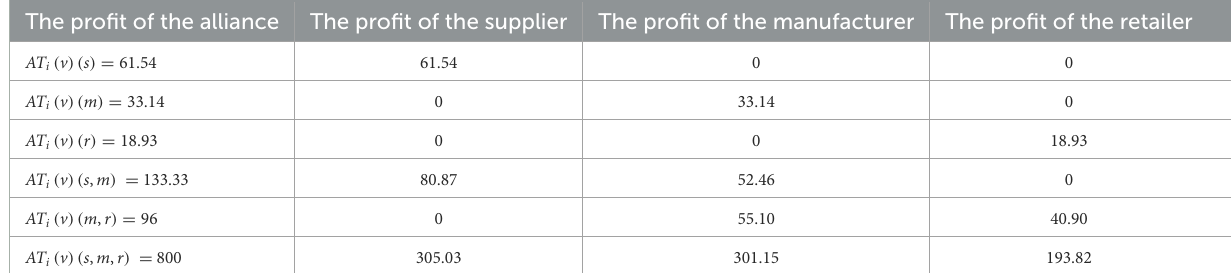
TABLE 6 Profits of different members. The profit of the alliance The profit of the supplier The profit of the manufacturer The profit of the